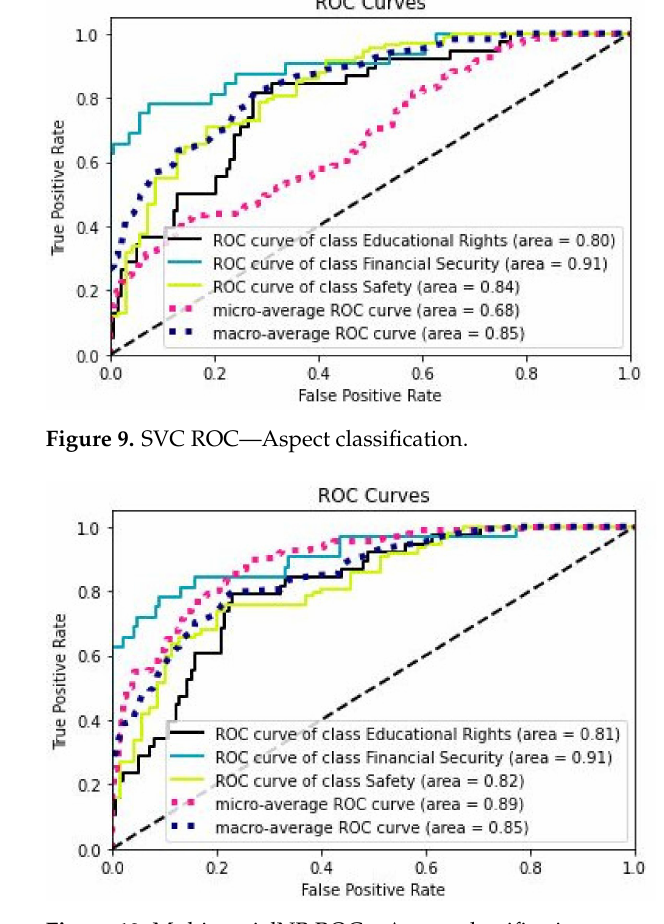
Figure 10. MultinomialNB ROC—Aspect classification.